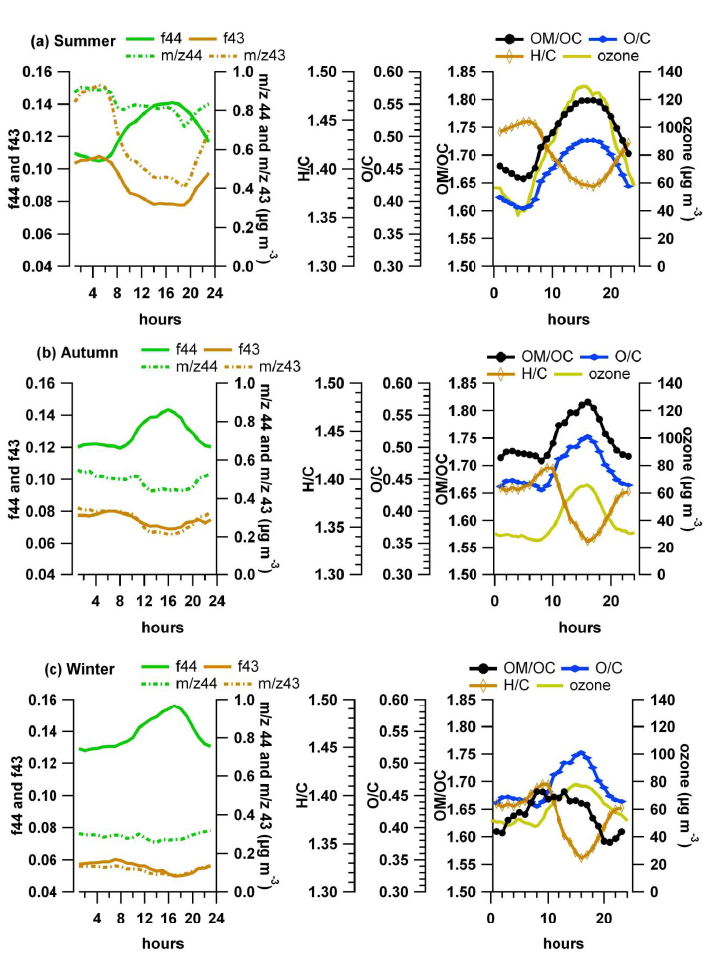
Fig. 3. Diurnal variations of the organic aerosol tracers ( m/z 44, m/z 43, f 44, f 43), OM/OC , O/C and H/C ratios and ozone concentration for (a) summer, (b) autumn and (c)